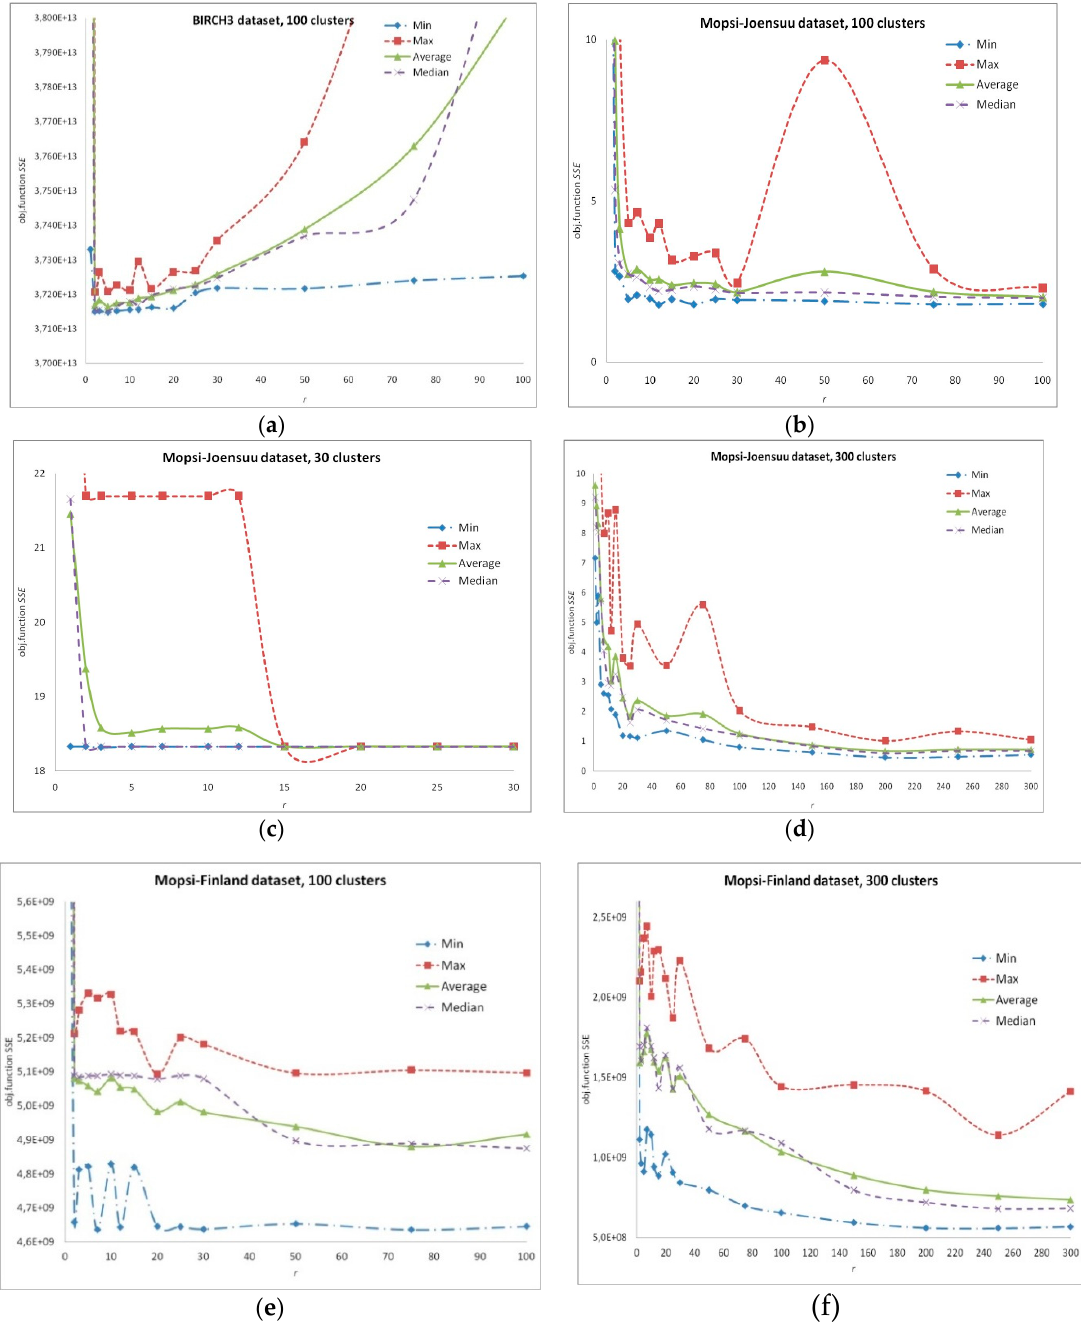
Figure 2. Search in GREEDY r neighborhoods. Dependence of the result on r : ( a ) BIRCH3 data set, 100 clusters, 10 5 data vectors, time limitation 10 s; ( b – d ) Mopsi-Joensuu data set, 30, 100 and 300 clusters, 6014 data vectors, time limitation 5 s; ( e – f ) Mopsi-Finland data set, 100 and 300 clusters, 13,467 data vectors, time limitation 5 s.